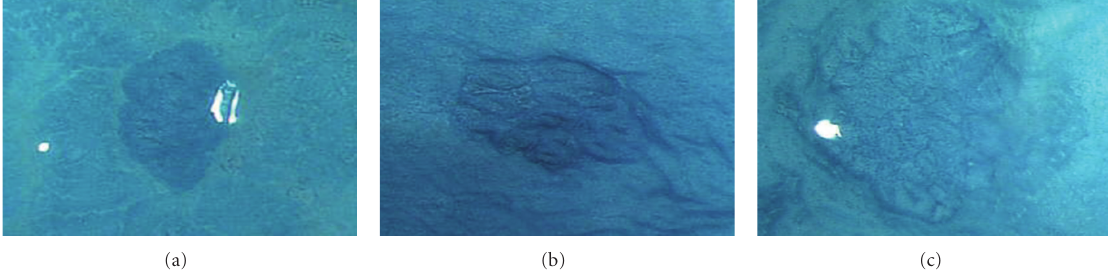
Figure 1: Typical features of ACF on magnifying colonoscopy with methylene blue staining. Table 2: E ff ect of PPAR γ ligand for human ACF and